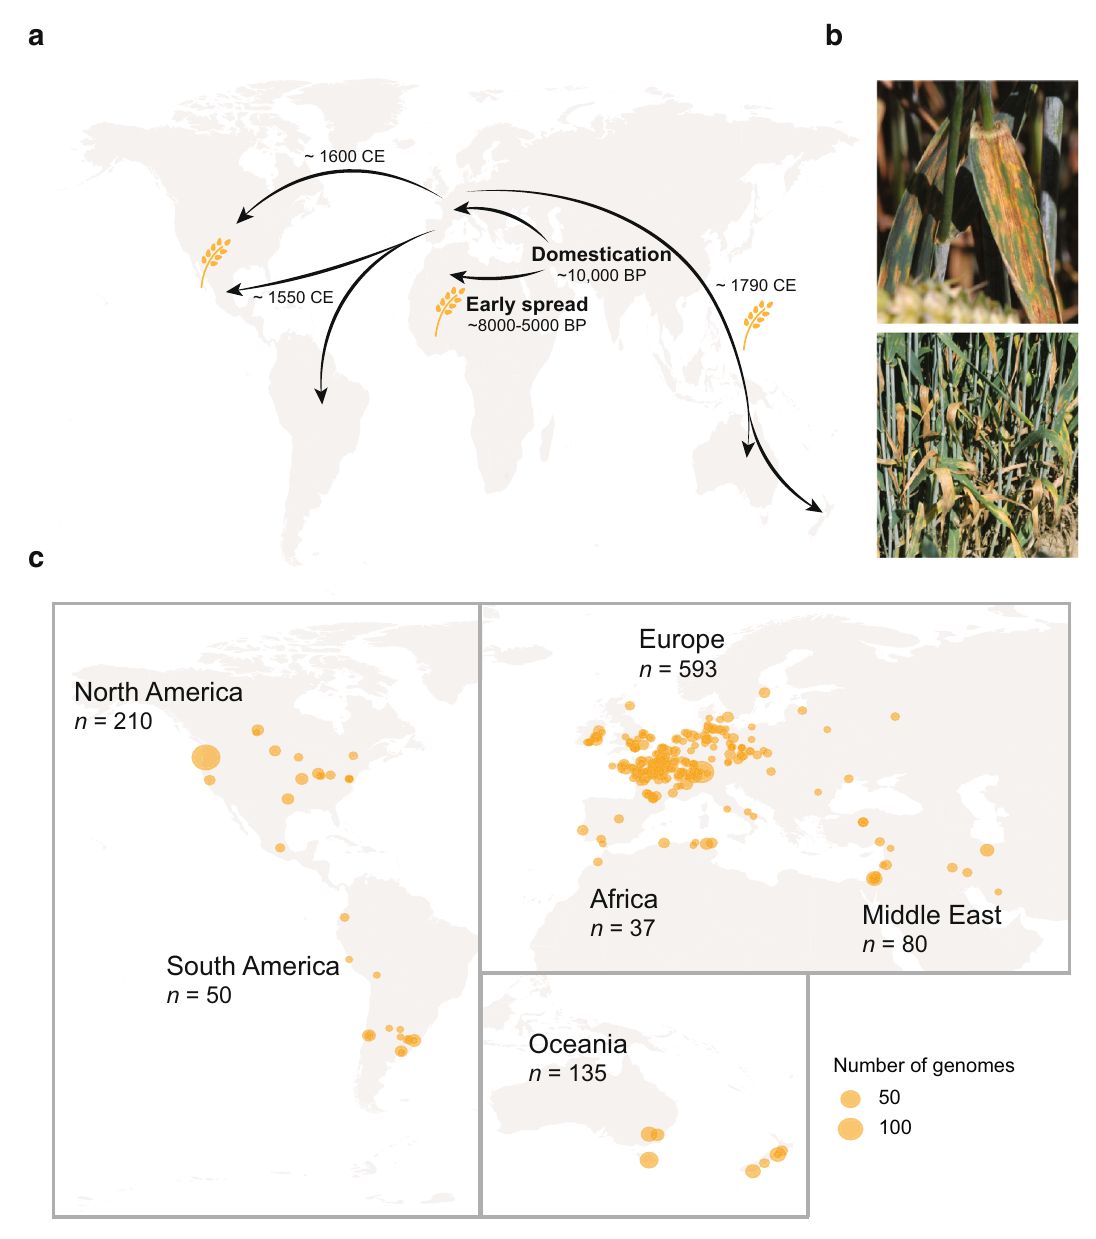
Fig. 1 | Global sampling of the wheat pathogen Zymoseptoria tritici retracing the historical spread of its host. a Schematic representation of the introduction of wheat across continents. b Septoria tritici blotch symptoms caused by Z. tritici